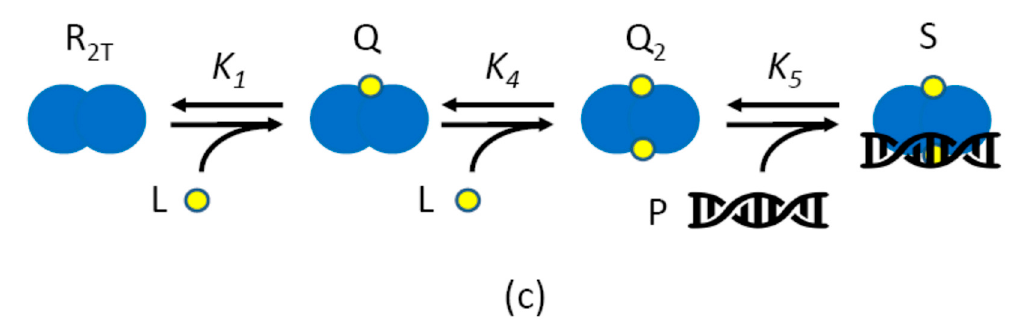
Figure 1. Description of the lux inducible system. ( a ) The gene encoding the LuxR protein transcriptional regulator is expressed by a constitutive promoter (P con ); the LuxR regulator becomes activated upon HSL molecule binding to form a complex which can bind the P lux promoter in its single lux box sequence, thereby activating the expression of the gene of interest (GOI), placed downstream of P lux . Curved arrows represent promoters; ovals represent ribosome binding sites (RBSs); straight arrows represent coding sequences; hexagons represent transcriptional terminators; circles represent HSL molecules. ( b , c ) Biomolecular reactions modeled in this work. The LuxR dimer (R 2T , blue overlapping circles) is assumed to be activated upon binding of one ( b ) or two ( c ) HSL molecules (L, yellow circles) to form an activated complex (Q or Q 2 , respectively), which binds DNA (double helix icon) to enable transcription. In panel ( c ), Q is the LuxR dimer form bound to one HSL molecule and it is assumed to be unable to bind DNA. The equilibrium constants are reported for each reaction occurring in panels ( b , c ).